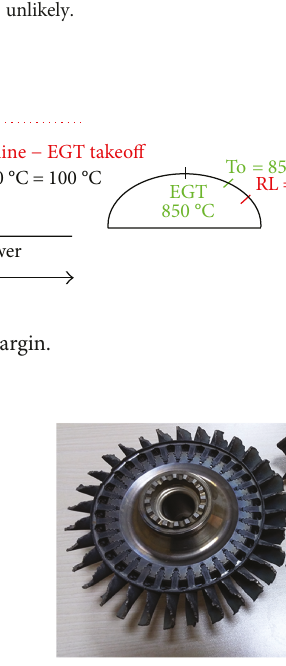
Figure 4: Sample faults in aircraft